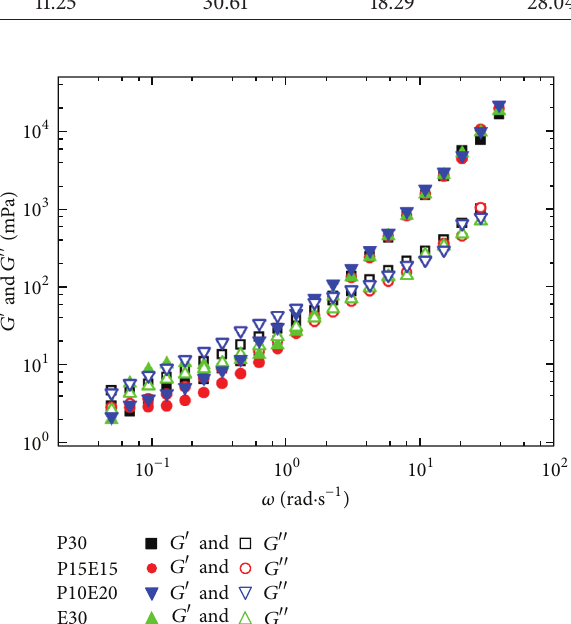
𝐺 󸀠 ) and loss modulus ( 𝐺 󸀠󸀠 ) plotted as a function of angular frequency ( 𝜔 ) for the samples (TDS = 32,868 mg/L, [Ca 2+ ] + [Mg 2+ ] = 873 mg/L, T = 85 ∘